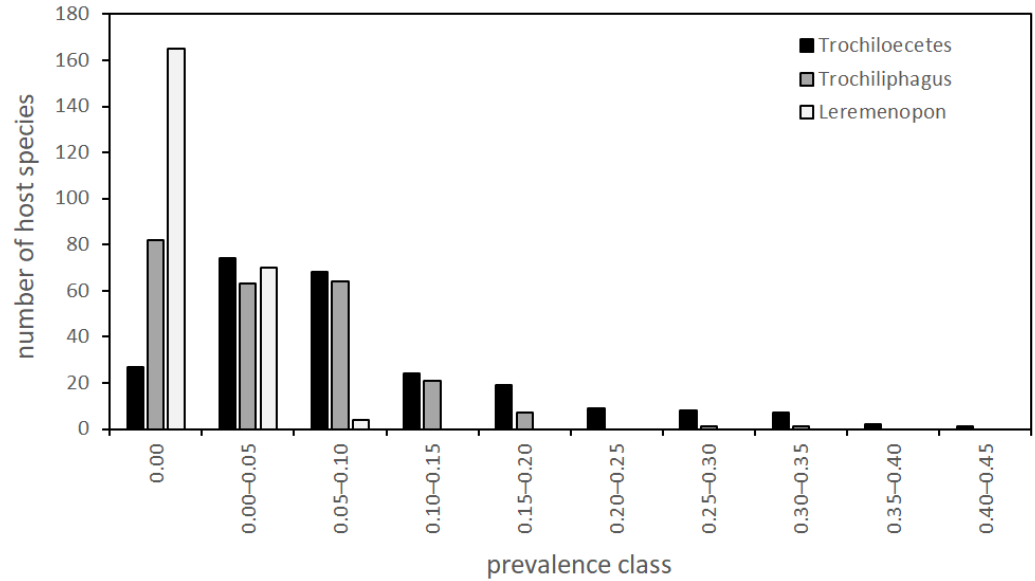
Figure 1. The distribution of 239 hummingbird taxa (N ≥ 50 individuals) across prevalence classes, shown separately for the three parasite genera ( Trochiloecetes , Trochiliphagus and Leremenopon ).